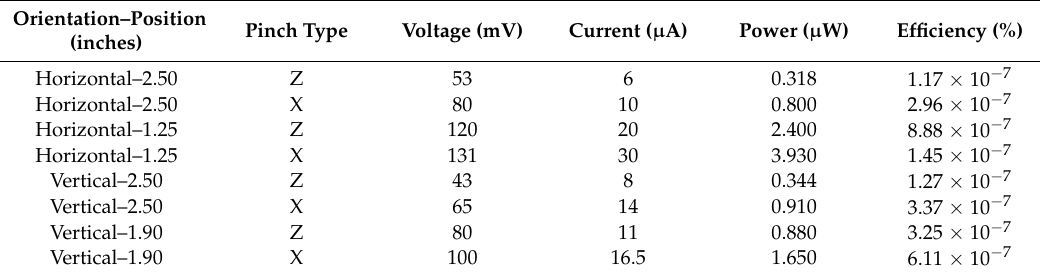
Table 2. The results of power and efficiency from the single and double